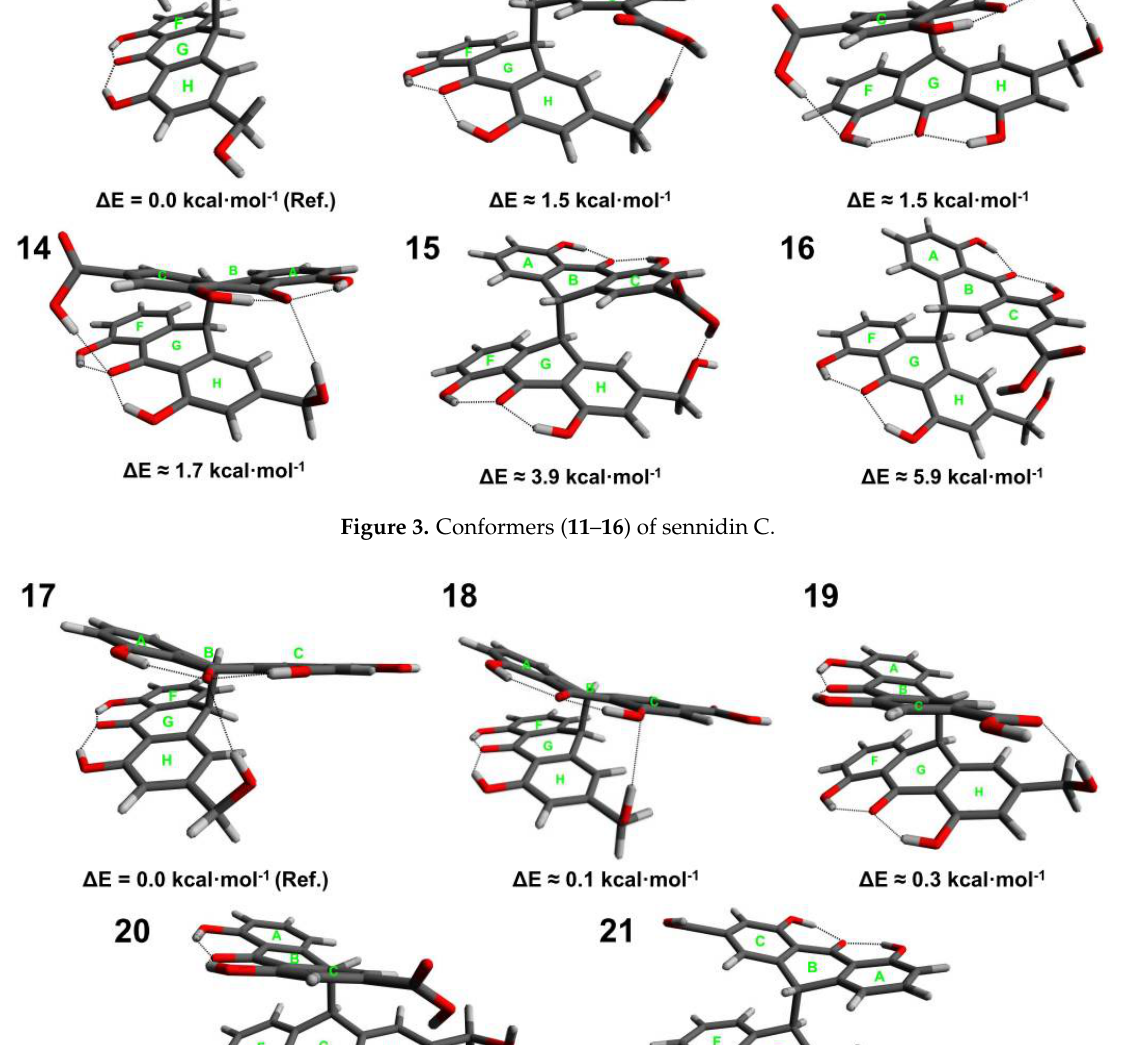
5 of 19 Figure 2. Conformers ( 7 – 10 ) of sennidin B.